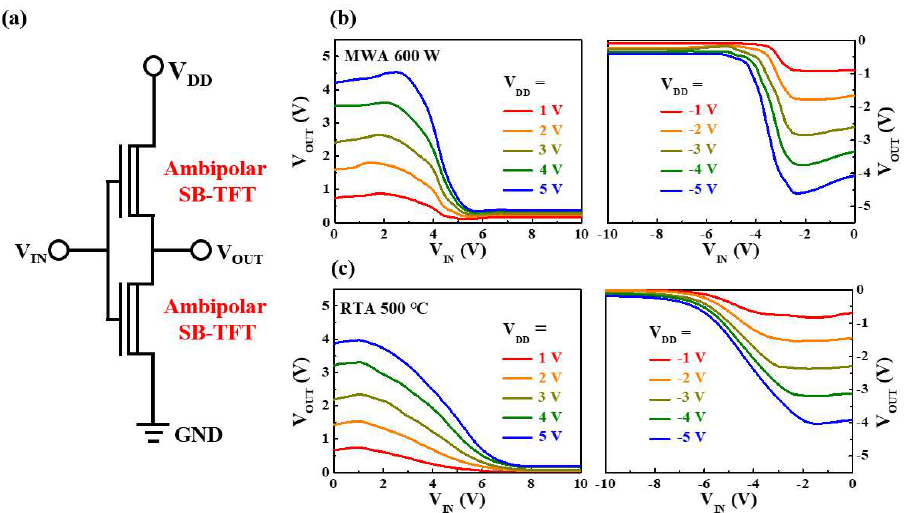
Figure 11. ( a ) Schematic diagram of an inverter circuit composed of two ambipolar NiSi x SB-TFTs; ( b , c ) the VTCs of the CMOS-like inverter in the first (left) and third (right) quadrants in ( b ) the MWA SB-TFT configuration (supply voltages V DD = ± 1–5 V), and ( c ) the RTA SB-TFT configuration. The extracted voltage gains (| ∂ V OUT / ∂ V IN |) in the first and third quadrants of the VTC curves at various V DD values are plotted in Figure 12. In both inverter circuits, the voltage gain is seen to increase with increasing V DD . Moreover, the voltage gain is seen to be larger for the MWA device than for the RTA device, which is due to the high drive current and low leakage current of the MWA SB-TFTs. Accordingly, the MWA device exhibits superior inverter characteristics, and a steeper switching slope, than the RTA